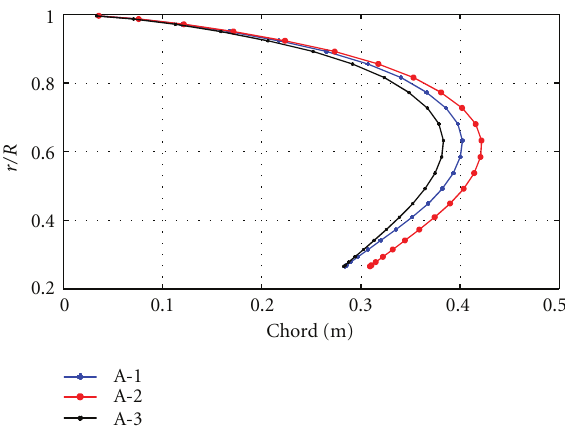
Figure 13: Chord lengths, fore propeller.